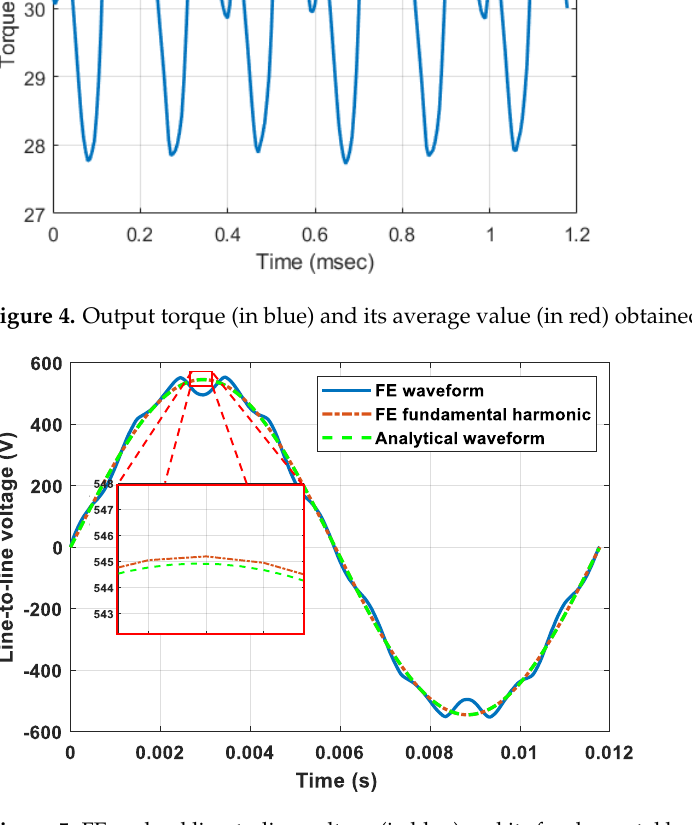
Figure 6. Comparison in terms of flux density in the airgap, teeth, and yoke. 4.2. Effective Parameters Considering the analytical equations reported in Section 2.2, it is clear that several parameters can be utilized to achieve the main design objectives of this work, i.e., power density maximization and power losses minimization. Thus, a sensitivity analysis is performed. While the results of this study can vary depending on the power range, the geometrical and magnetic features, the airgap thickness, etc., of the PMSM motor under analysis, for the case study considered in this paper the sensitivity study can provide useful information for a first exploration of weight allocation during optimization. As- suming the hairpin motor of the previous section as the benchmark, the parameters used for the sensitivity study are normalized over the corresponding values of the benchmark machine. Figures 7 and 8 show the total power losses and volume power density for the four input parameters, i.e., pole pair number, slot per pole per phase number, conductor